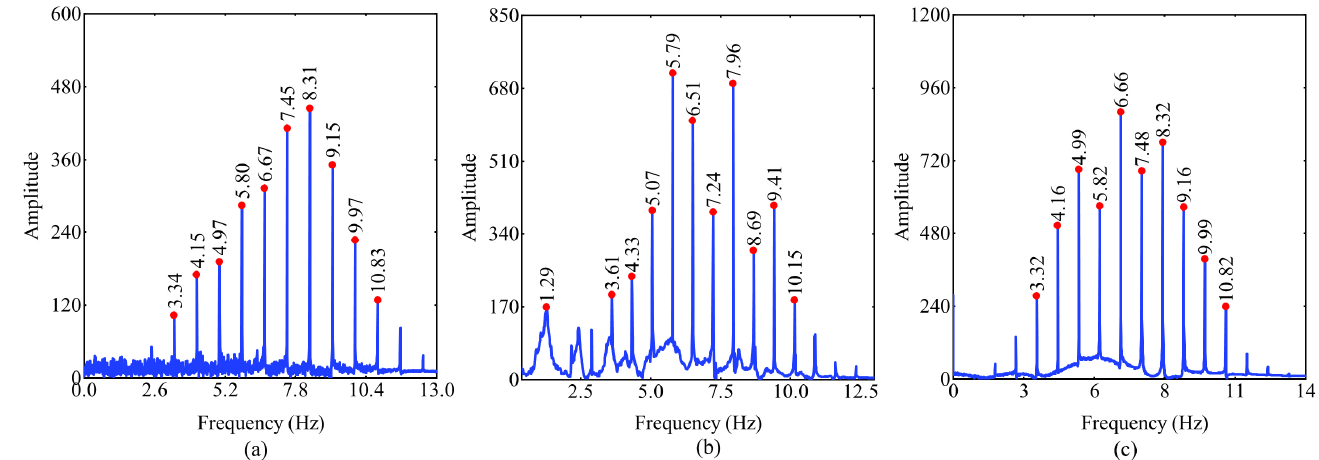
Figure 10. Fast Fourier transform results of the full-scale model experiment: ( a ) Condition 1, ( b ) Condition 2, ( c ) Condition 3.